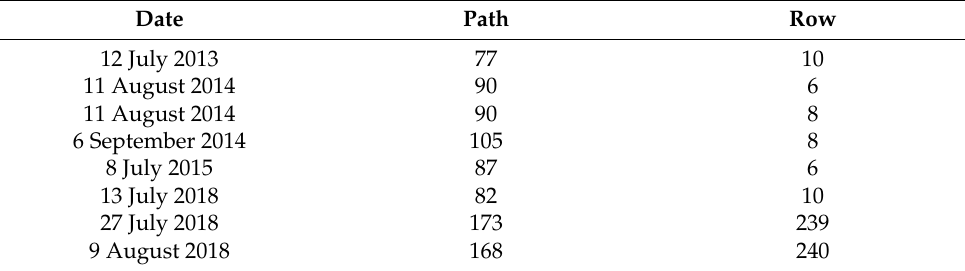
Table 1. Details of the Landsat-8 OLI data used in this